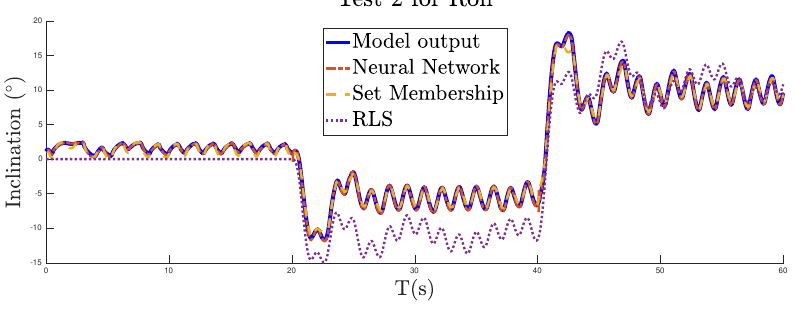
Figure 16. Test 2 results for roll.